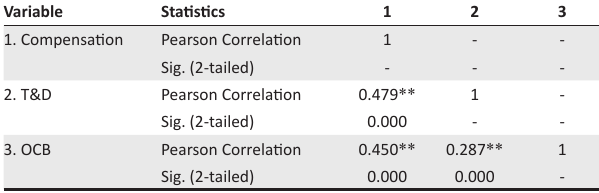
TABLE 4 : Correlations between compensation, training and development and organisational citizenship behaviour ( N = 152).